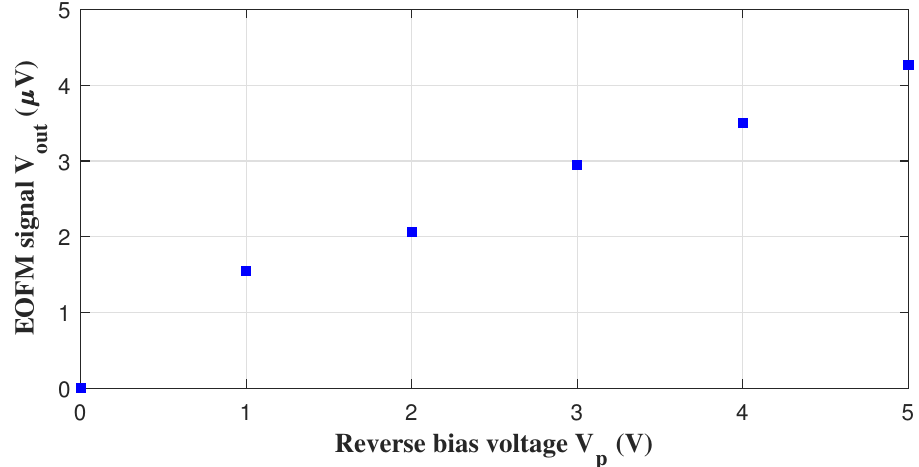
Figure 6. EOFM signal ∆ R calculated for different voltages